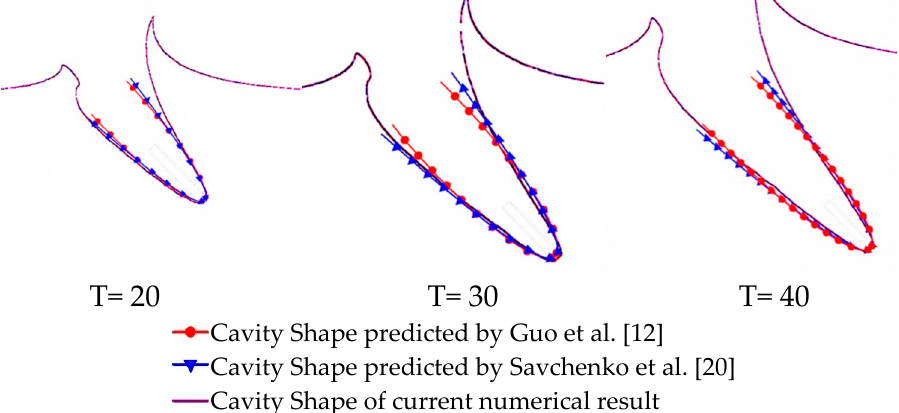
Figure 3. between the cavity evolution of numerically result and predicted by the analytical cavity